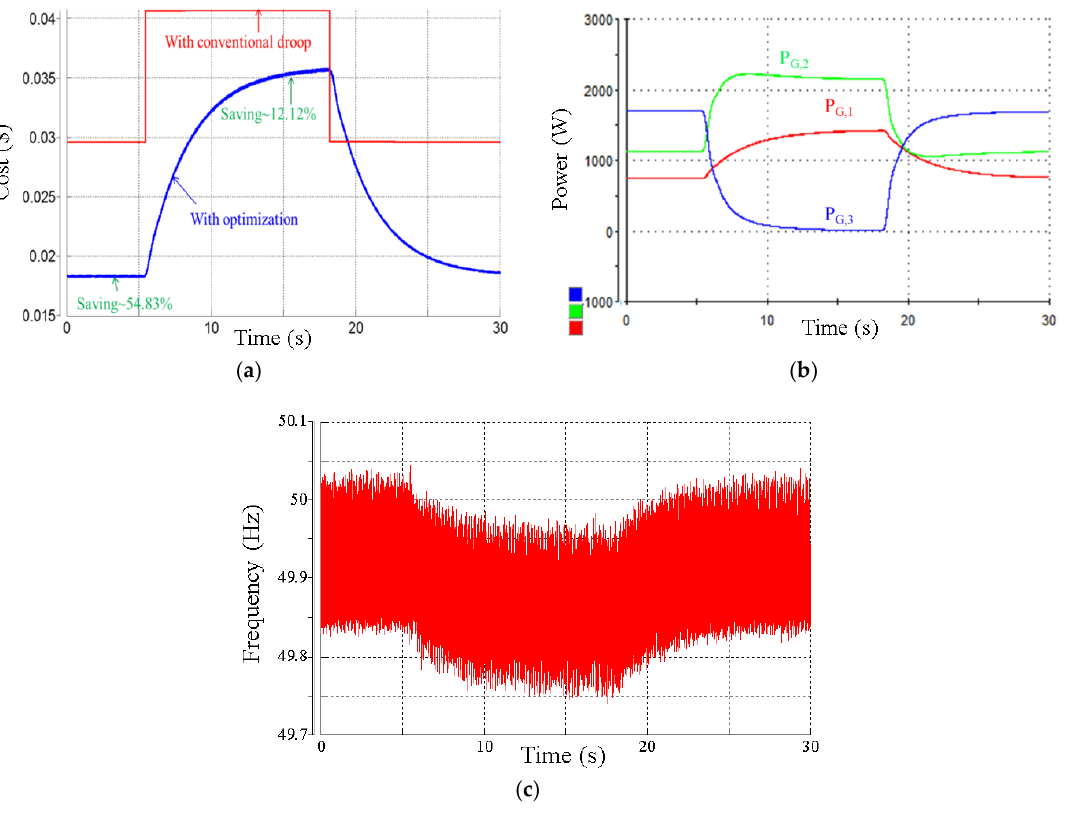
Figure 15. Experimental results of transient response with one DG unit disconnected with proposed algorithm. ( a ) operation cost; ( b ) real power; and ( c ) frequency given.